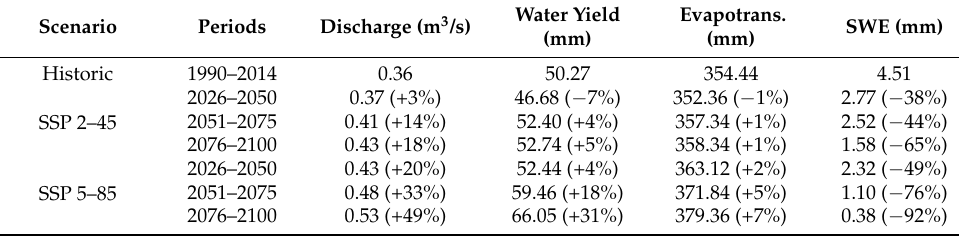
Table 6. Annual average of the water cycle components in the Erken basin. Ensemble of the GCMs.